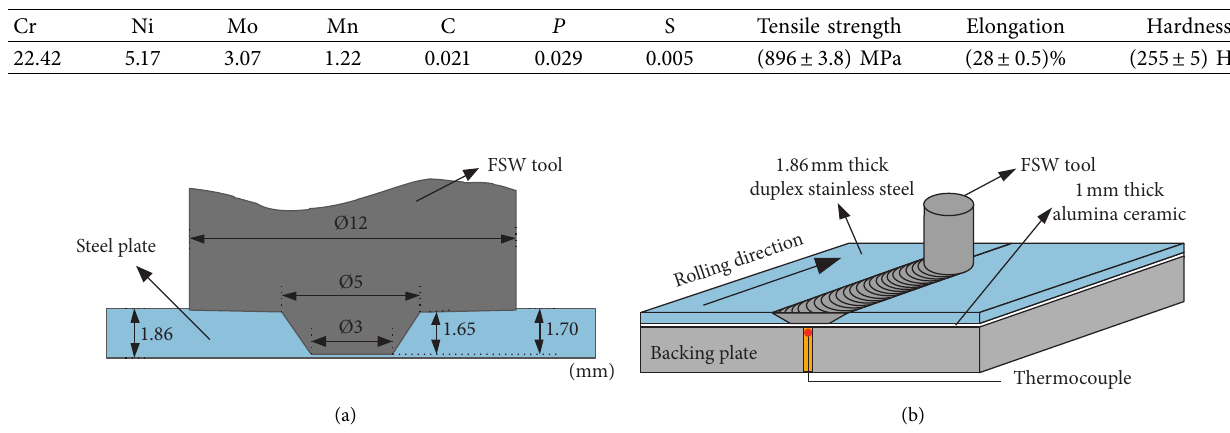
Table 1: Chemical composition (wt%) and mechanical properties of BM.